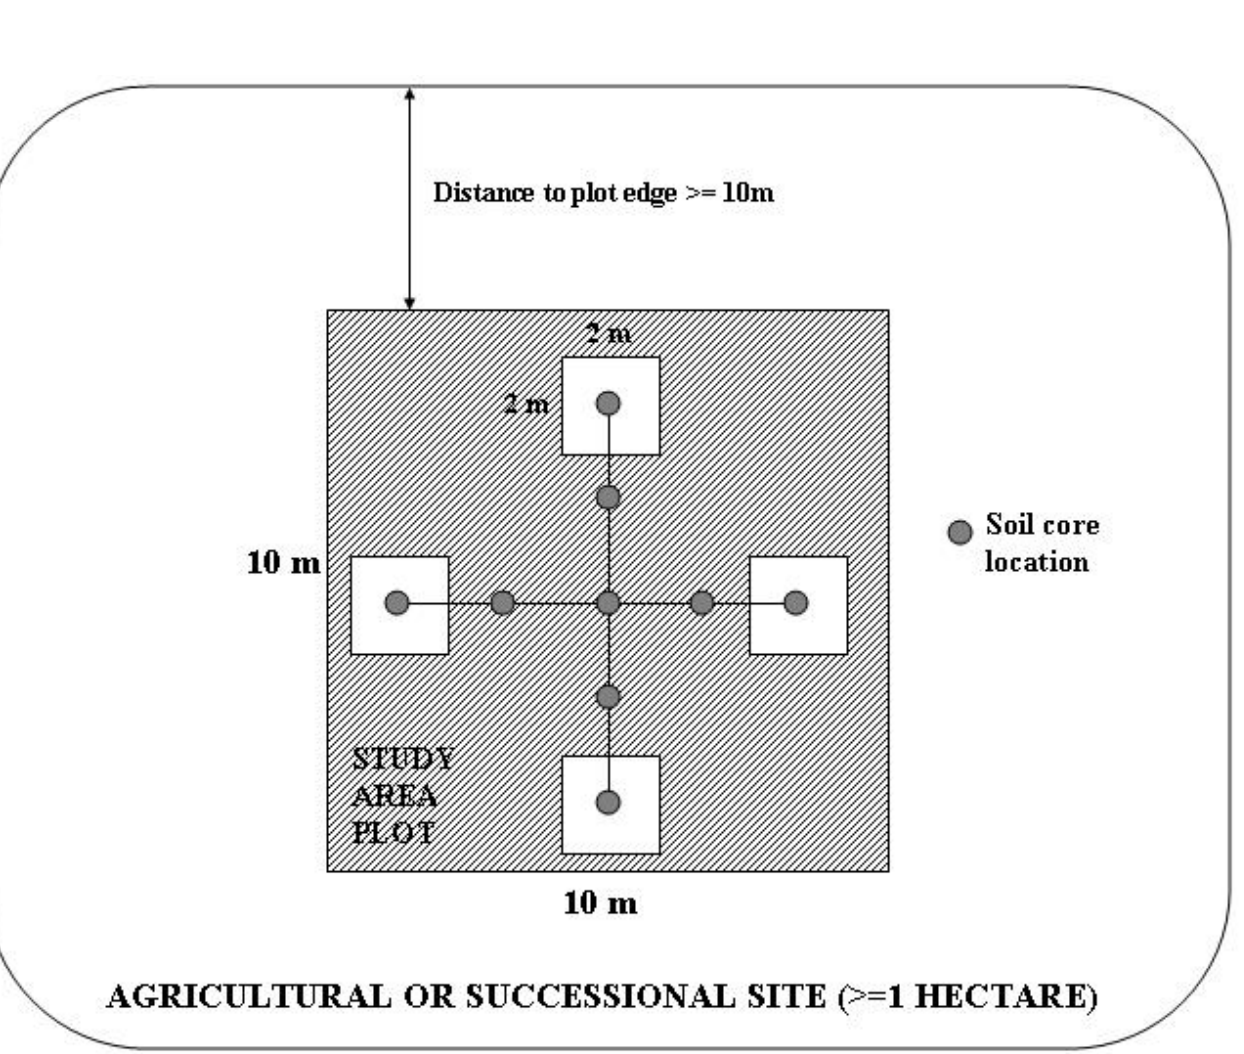
Fig. 3. Nested sampling